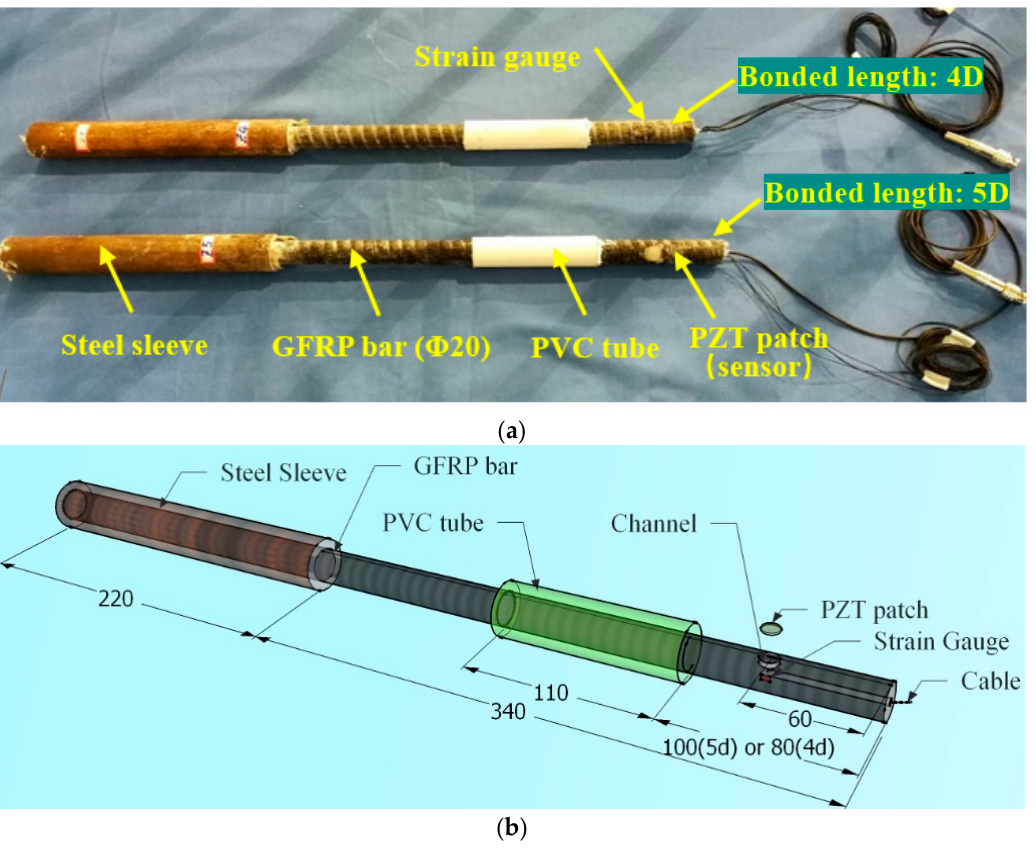
Figure 4. GFRP bars embedded with PZT patch sensor: ( a ) a photo of the GFRP bars used in the pull-out tests; ( b ) installation of the PZT sensor. (Unit: mm.)